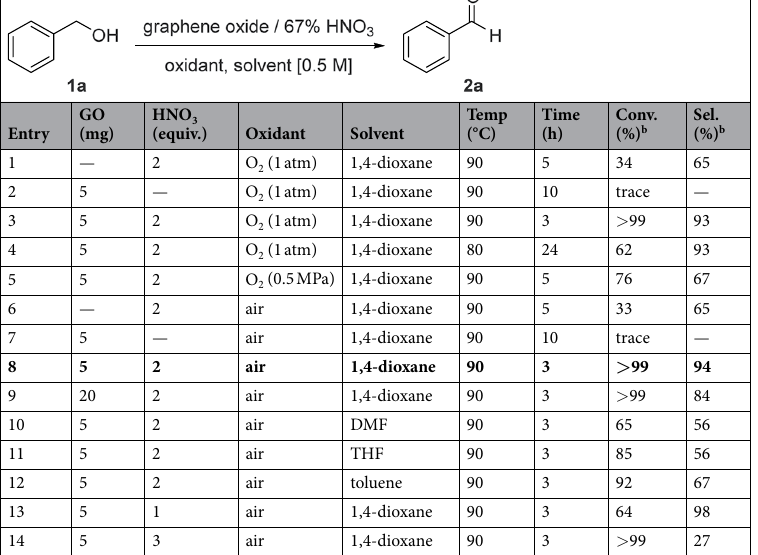
acid, only a trace amount of desired product 2a was detected after 10 h (Table 1, entry 2). Gratifyingly, a signif- icant improvement in conversion ( > 99%) and selectivity (93%) was achieved when the reaction was carried